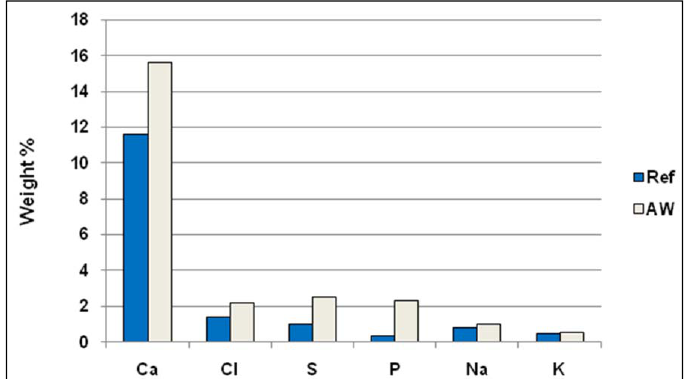
Figure 7. Average element concentrations in the coating surrounding the sand